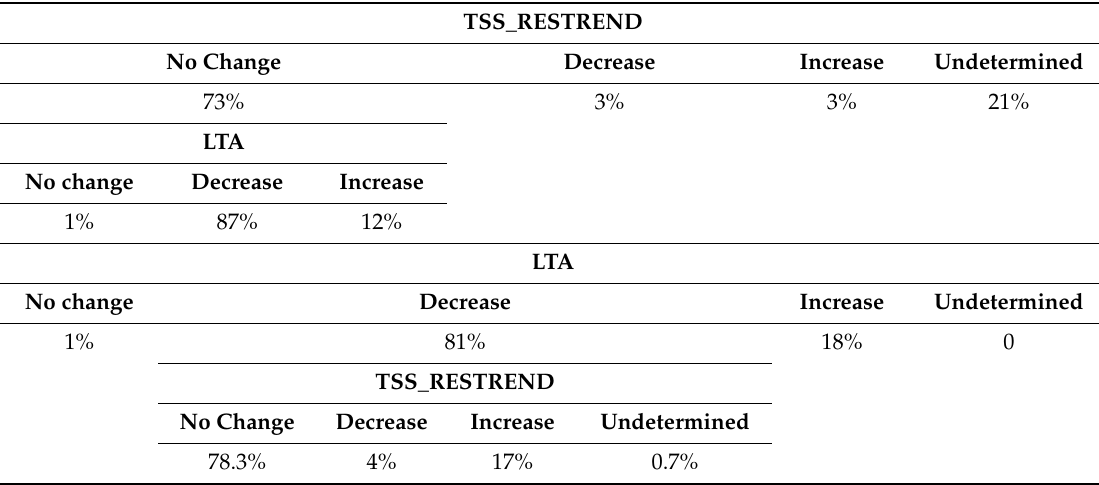
Table 3. NDVI changes results between TSS-RESTREND and LTA in Hulunbuir.